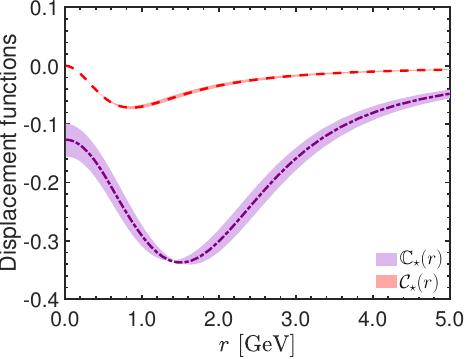
( r ) (red dashed) obtained from the C (cid:63)